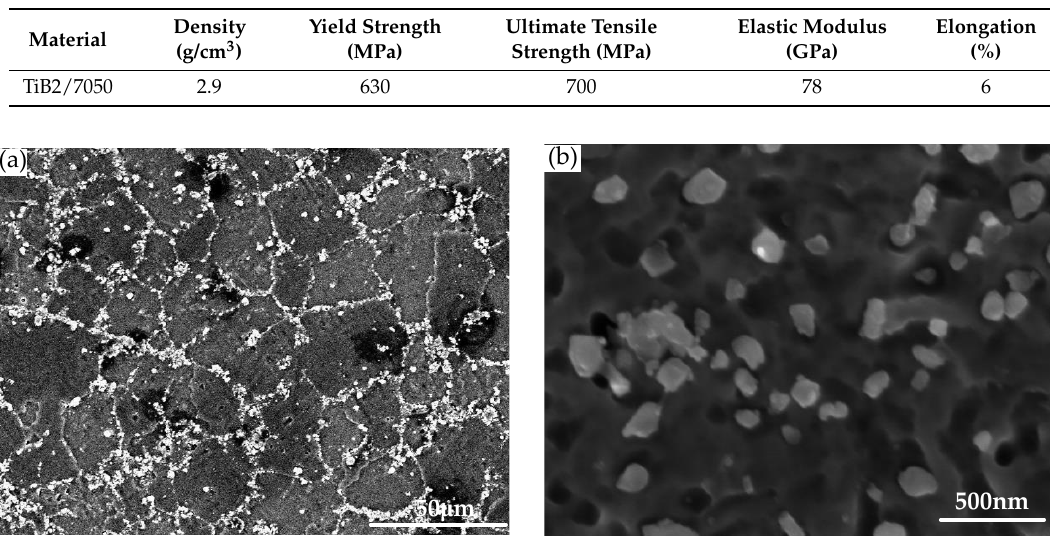
Figure 1. Microstructure of TiB 2 /7050 Al composite: ( a ) SEM image shows the distribution of TiB 2 particles; ( b ) magnified TiB 2 particles aggregated along the grain boundaries.